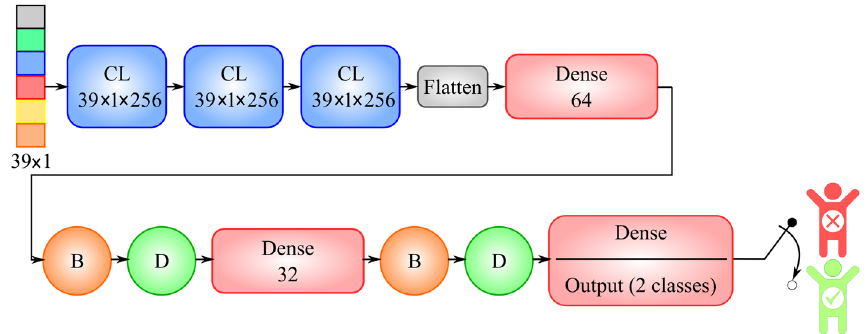
Figure 6. Implementation details of CNN. ‘CL’ and ‘Dense’ represent convolutional and fully connected layers, respectively. Circles with the letter ‘B’ represent batch normalisation layers, and circles with the letter ‘D’ represent dropout layers with a probability 0.5.